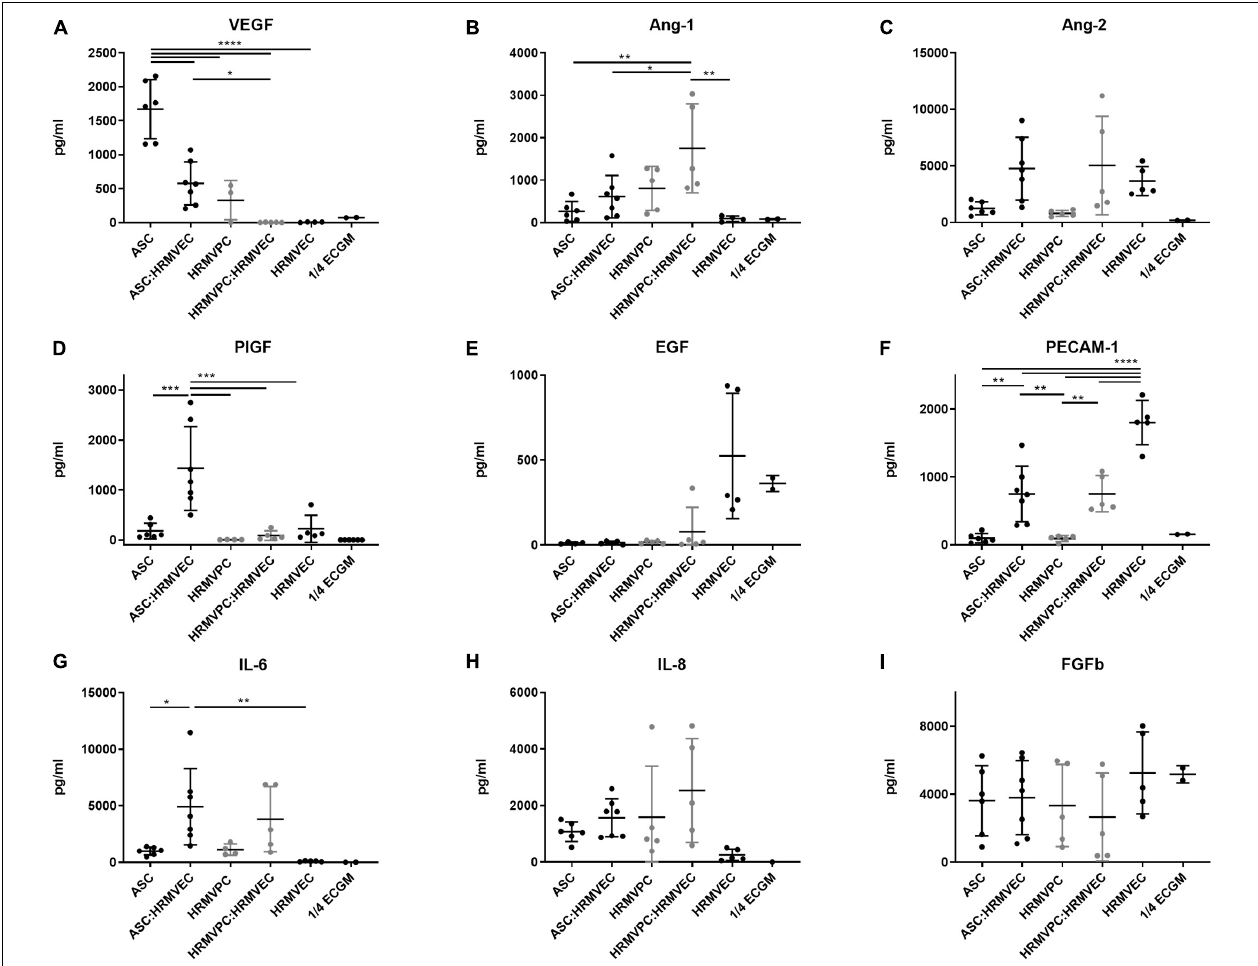
FIGURE 5 | Conditioned medium composition differs significantly between adipose-derived stromal cells (ASC) and human retinal microvascular pericytes (HRMVPC). Angiogenic growth factor levels (A–I) of conditioned cell culture supernatants (CM) of mono- or cocultures measured by flow cytometry-based